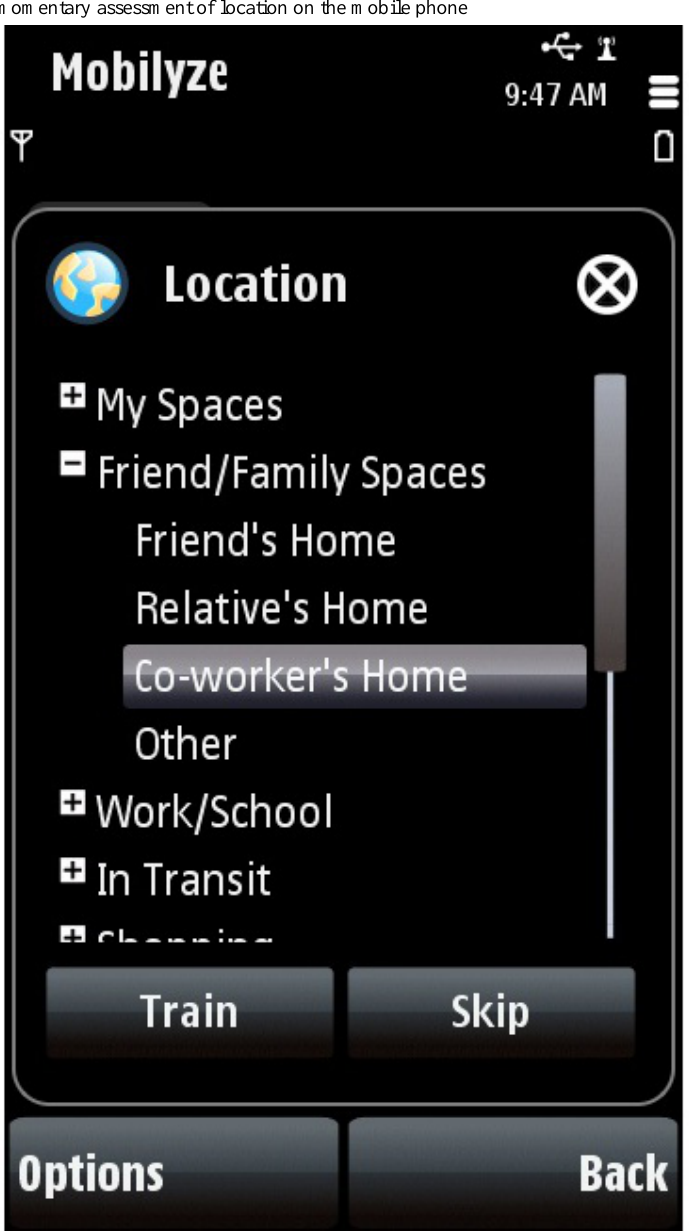
Figure 3. Screenshot, ecological momentary assessment of location on the mobile